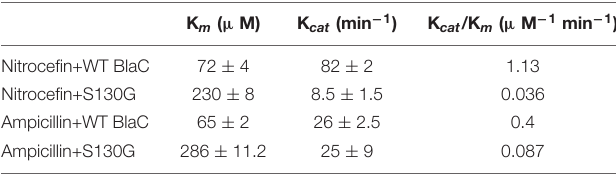
Table 1 | Steady-state kinetic parameters of wild-type BlaC and its variant S130G toward nitrocefin and